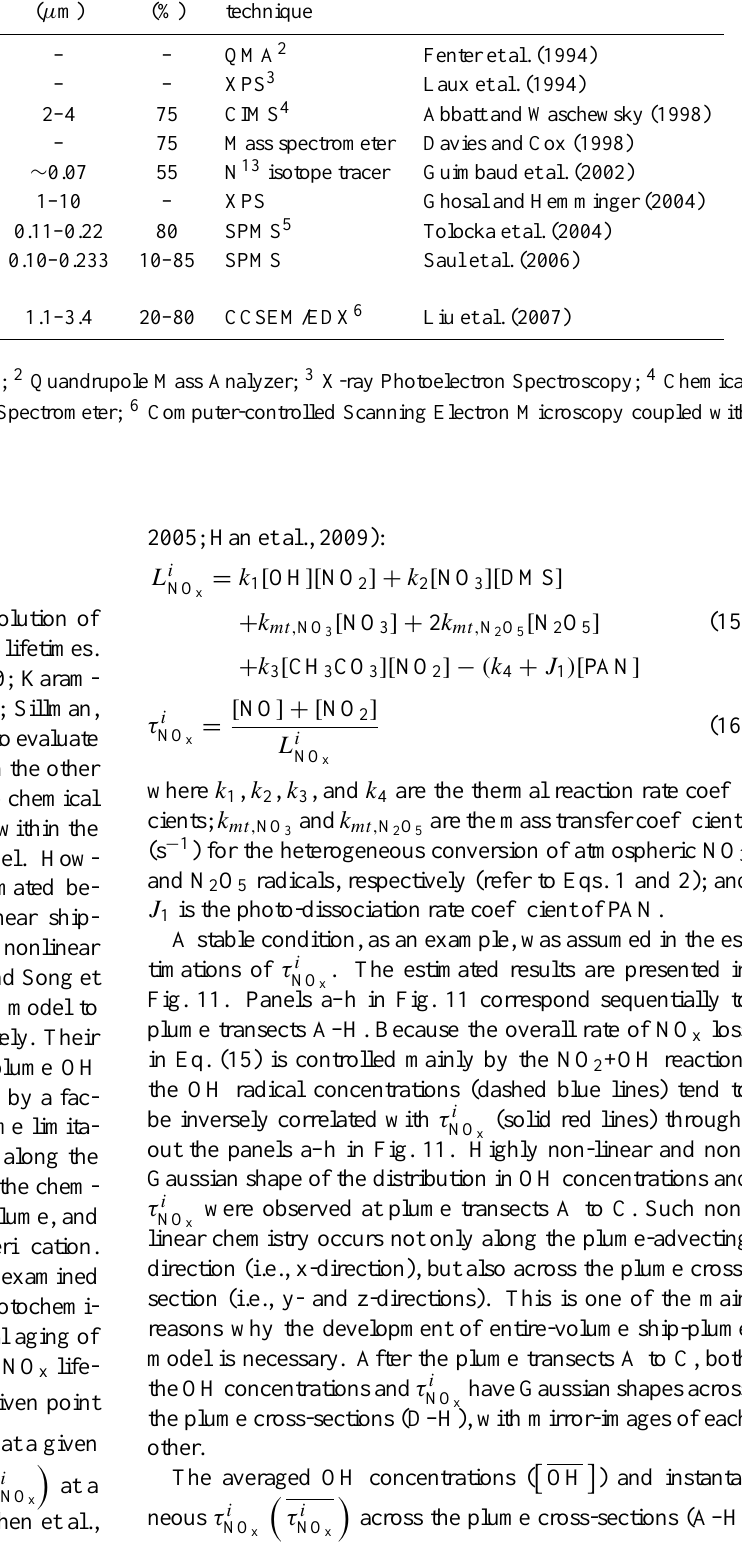
Table 4. Uptake coefficients of HNO 3 (g) onto NaCl and sea-salt particles. Type of aerosol Uptake coefficient, D p 1 RH Experimental Reference γ HNO technique 3 NaCl, NaBr, KCl, and